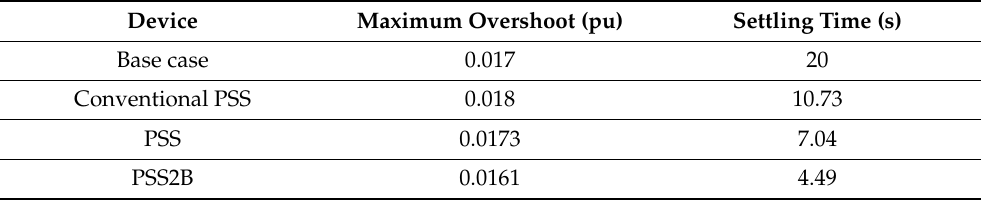
Table 13. Maximum overshoot and settling time of rotor speed at normal